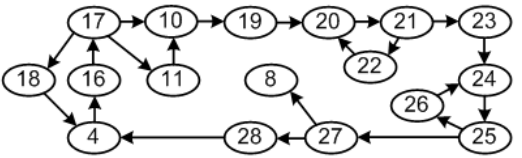
Fig. 3. Topological space part that represents detailed functionality of checkout sub-process.